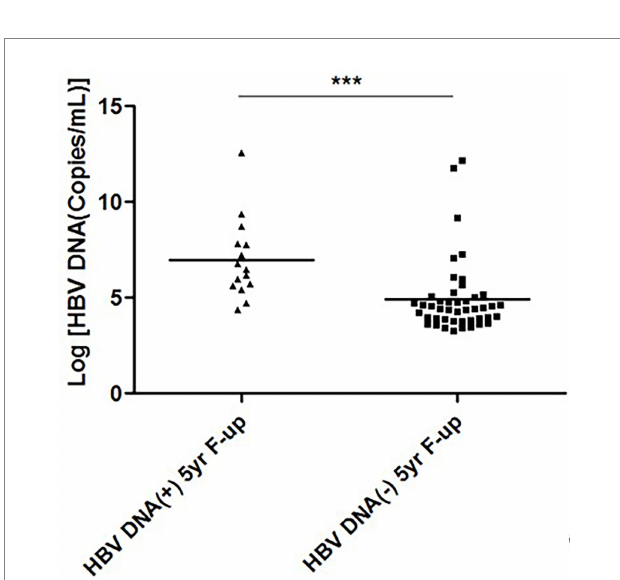
FIGURE 2 Hepatitis B virus (HBV) DNA levels at study commencement and HBV DNA-negativity 5-years after end of treatment. The levels of HBV DNA (log copies/ml) of two groups of patients at the time of study commencement has been cited. The levels of HBV DNA were lower in patients who became HBV DNA negative 5-years after end of treatment, compared to those who remain HBV DNA-positive 5-years after end of